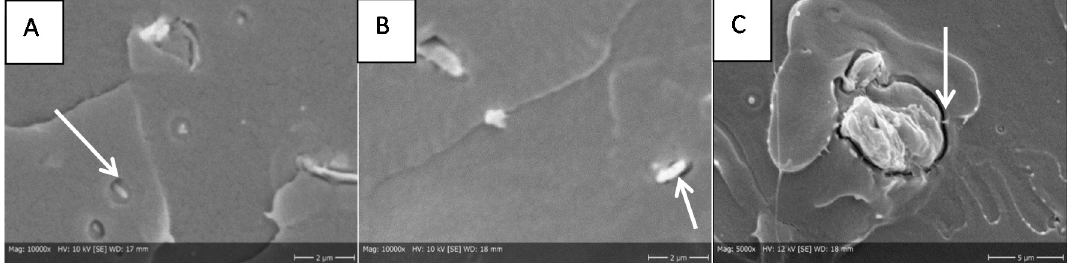
Figure 5. SEM image of injection molded test bars. ( A ) PLA with CNF, ( B ) PLA with HefCel CMF and ( C ) PLA with MC. Fiber loading 5%. Arrows are indicating a gap between the fiber and polymer.